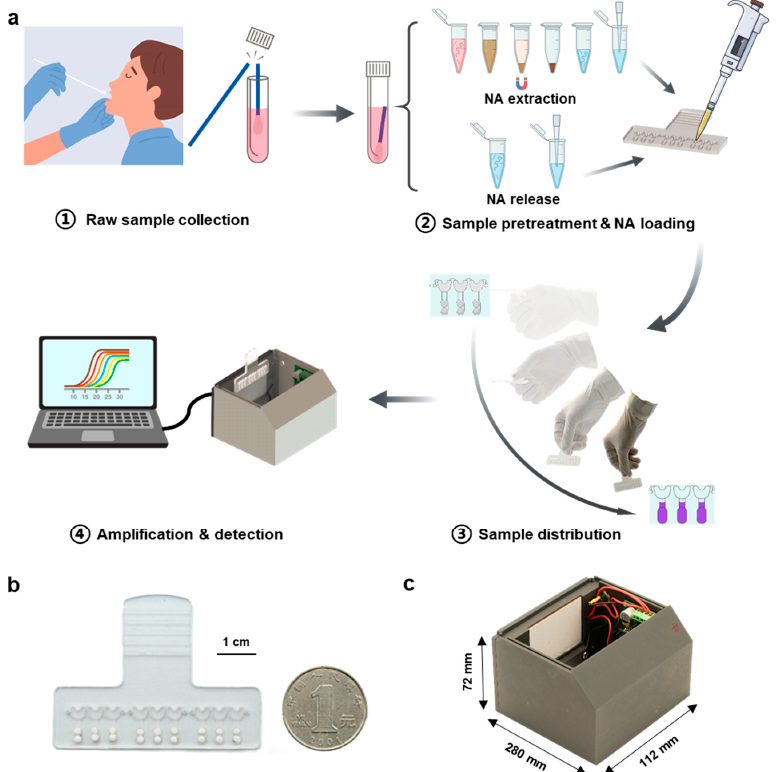
Figure 1. Workflow of the SMART system. ( a ) Four steps for NA testing using the SMART system: ① Nasopharyngeal swab collection, ② NA extraction or release from the swab and NA sample pathogens by inserting the chip into the support analyzer. ( b ) The photograph of an assembled hand-driven chip. ( c ) The photograph of the supporting